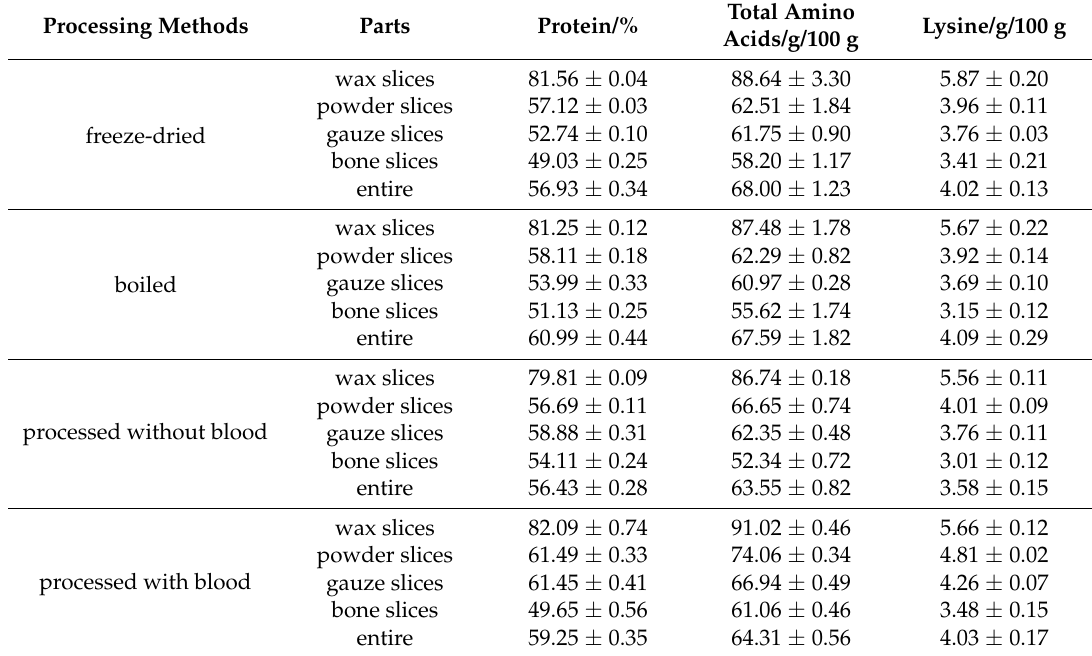
Table 2. Protein, total amino acids, and lysine contents in the processed velvet antler ( x ± SD, n = 3). Processing